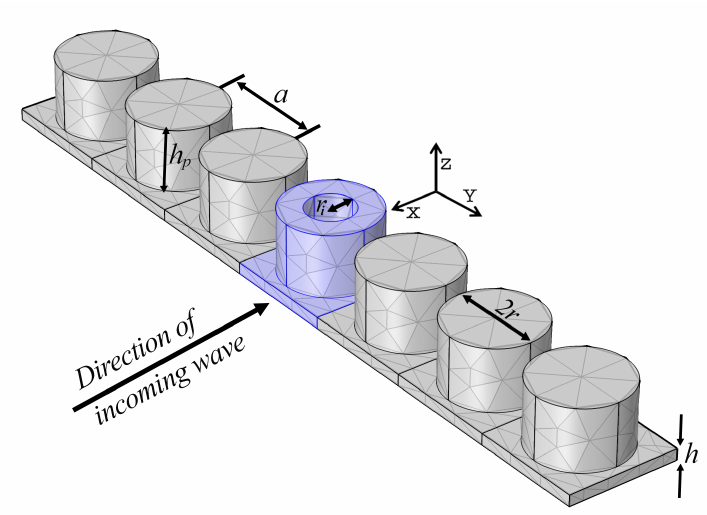
Figure 2. Supercell to simulate dispersion band